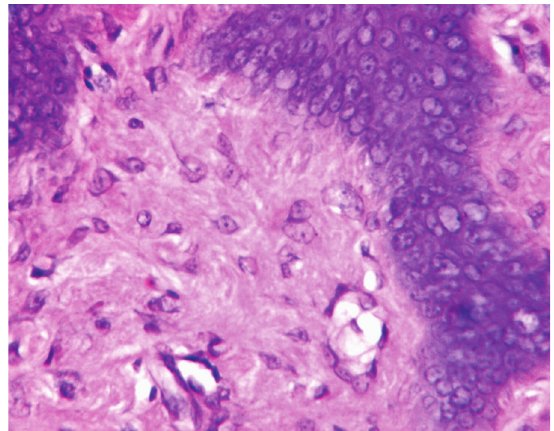
Figure 3: Photomicrograph showing giant fibroblasts with stellate shape and some contains two nuclei. (Hematoxylin and Eosin, orig- inal magnification